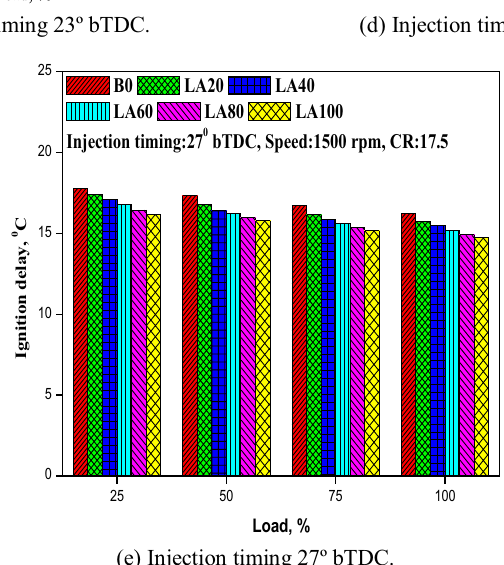
Figure 9. ( a–e ) The variation in ID with different FITs and engine load for considered fuel